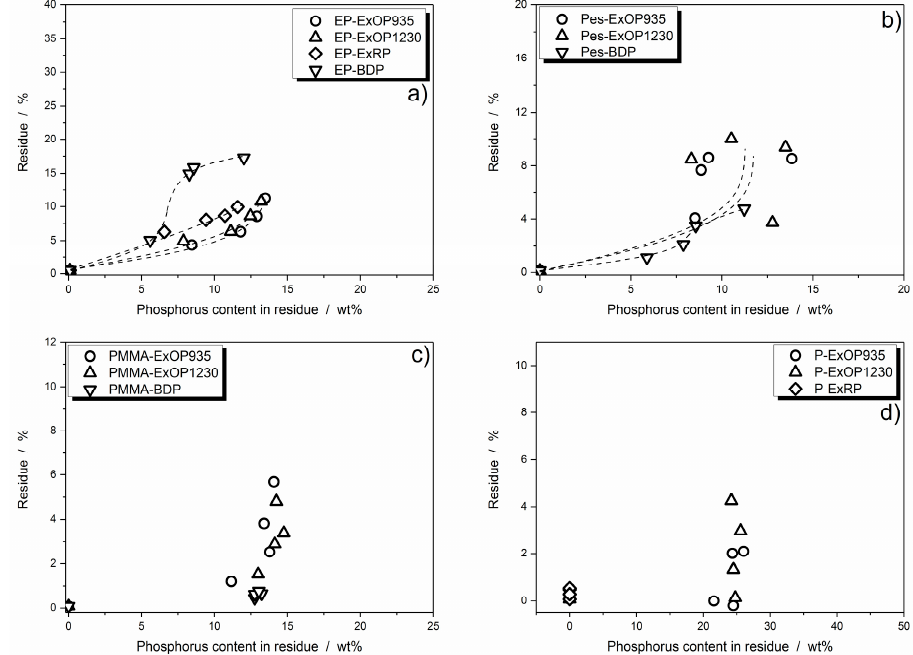
Figure 10. Residue plotted against the phosphorus content in the residue: DGEBA/IPDA ( a ); polyester ( b ); PMMA ( c ); and paraffin ( d ) system.